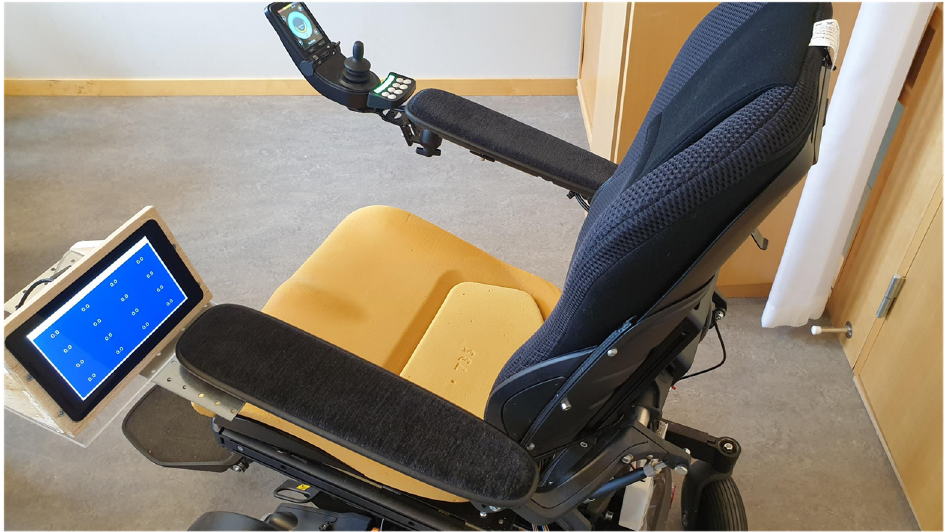
Figure 11. Standalone embedded system mounted on a wheelchair.